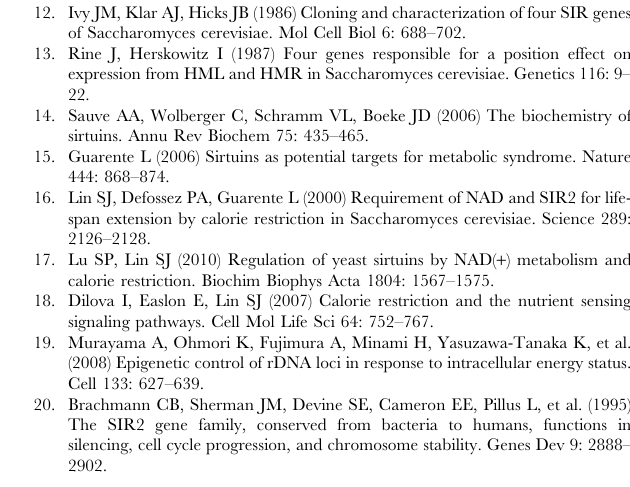
Table S1 The metabolic intermediates in aged and young cells. The signal peaks of the metabolic intermediates were converted and normalized to the resultant relative area values, including glucose metabolism intermediates, TCA cycle intermediates, and amino acids. The ratio of the resultant relative area values for aged and young cells is also given. Table S2 The metabolic intermediates in wild type and hst3 D hst4 D cells. The calculated amounts of the metabolic intermediates of central carbon metabolism are given. The ratio of the resultant relative area values for wild type and hst3 D hst4 D cells is also given. (XLSX) Table S3 The metabolic intermediates among wild type, tdh2 D , metabolic intermediates were converted and normalized to the resultant relative area values, including glucose metabolism intermediates, TCA cycle intermediates, and amino acids. The ratio of the resultant relative area values for aged and young cells is also given. (XLSX) Table S4 The pH of media of wild type, hst3 D hst4 D , tdh2 D